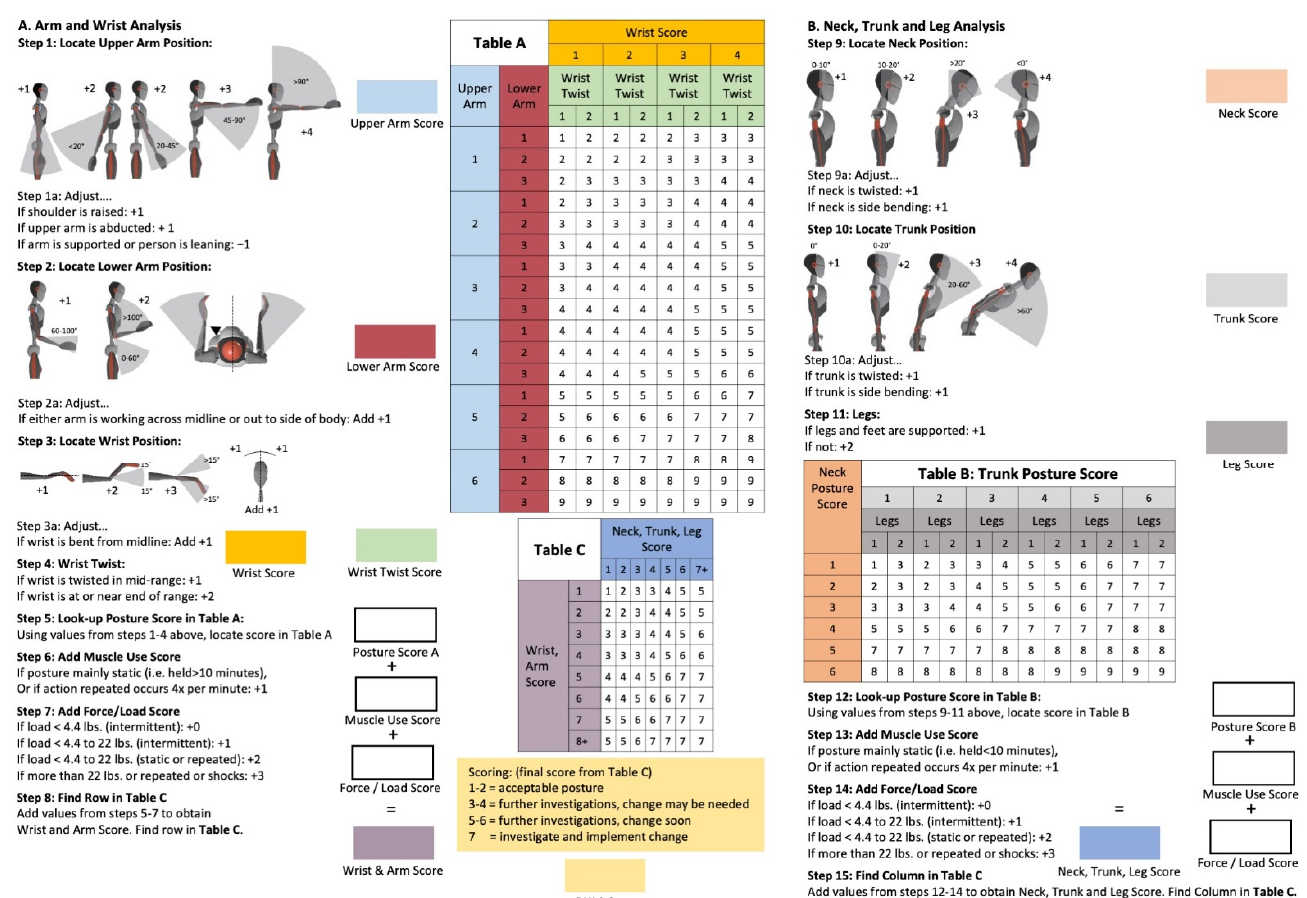
Figure 2. RULA worksheet including all relevant